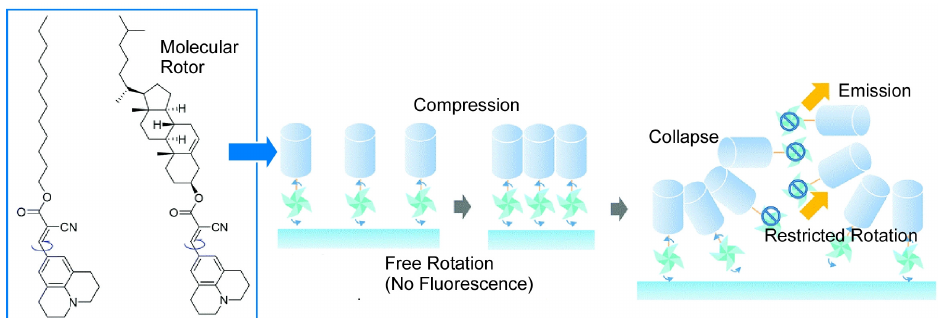
Figure 21. Rotational behavior of a twisted intramolecular charge trans-fer-type 9-(2-carboxy-2-cyanovinyl)julolidine derivative as a molecular rotor at the air-water interface. Reprinted with permission from Reference [188]. Copyright 2018 Royal Society of Chemistry.